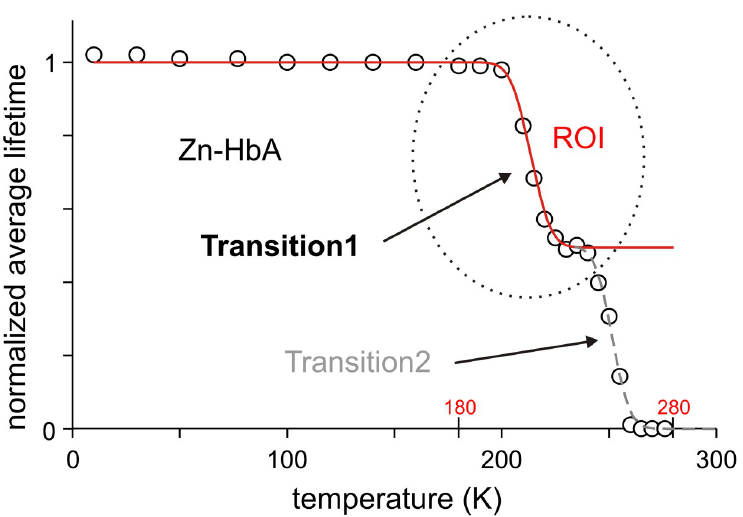
Fig 2. Normalized average phosphorescence lifetime values of Zn-HbA as a function of temperature measured in a stepwise warming process (open circles). Transition1 is marked as the region of interest (ROI). The continuous red curve corresponds to the fitted data points of Transition1 by our thermodynamic model. (Transition2 is marked with gray dashed curve).